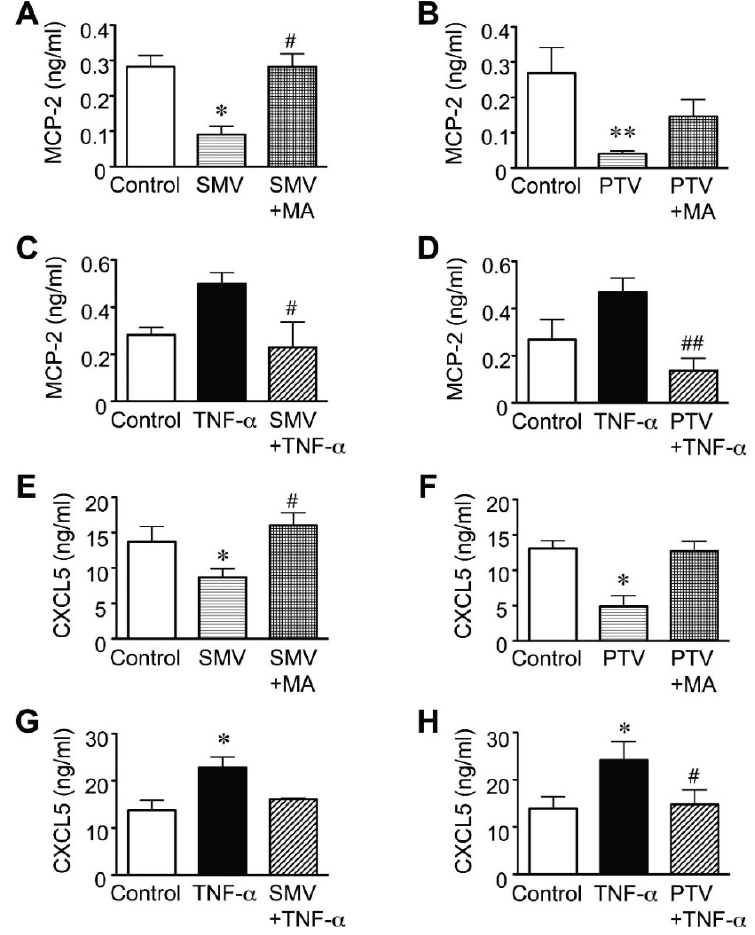
Figure 4. Effect of statins on chemokine secretion in human abdominal aortic aneurysm (AAA) wall. A human AAA wall was cut into small pieces and cultured with simvastatin (SMV, 10 μ M), pitavastatin (PTV, 20 μ M), mevalonate (MA, 100 μ M), tumor necrosis factor (TNF)- α (50 ng/mL) or vehicle (control). ( A – D ) Levels of monocyte chemoattractant protein (MCP)-2 secretion in the conditioned media were analyzed ( n = 5). Data are the mean ± standard deviation (SD). * p < 0.05 and ** p < 0.01 compared to the control; # p < 0.05 compared to SMV or TNF- α ; ## p < 0.01 compared to TNF- α ; ( E – H ) Levels